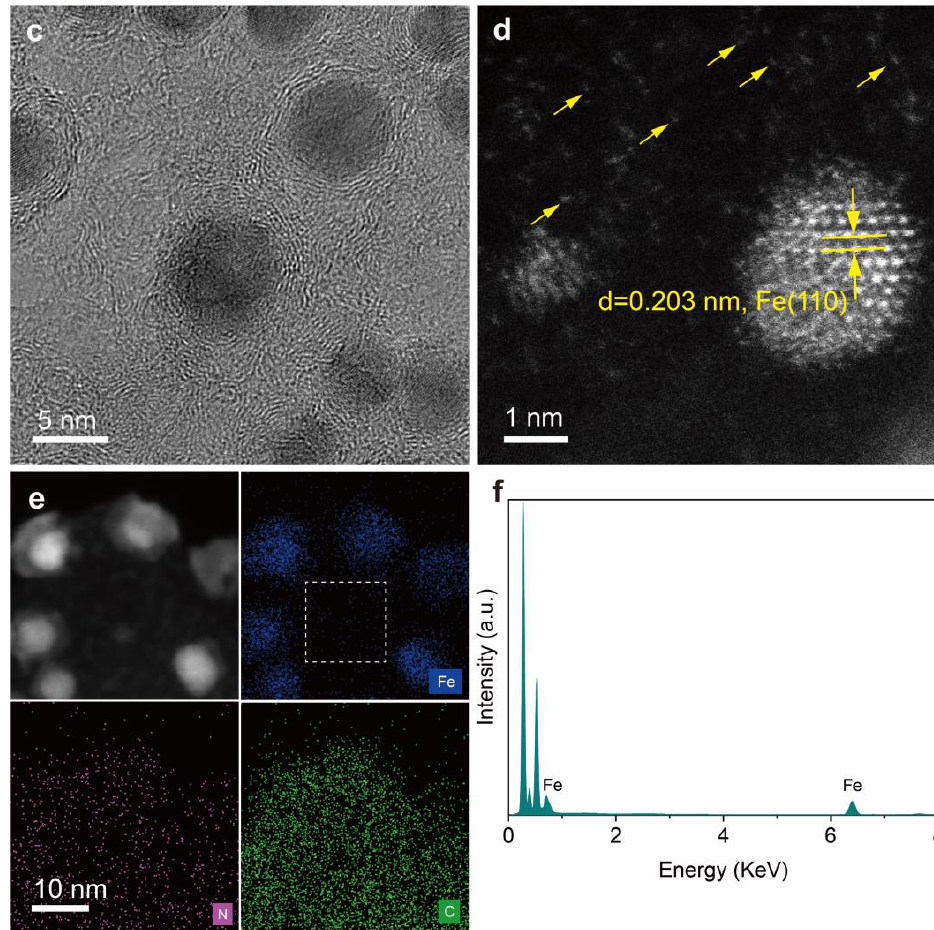
Figure 2. Microstructural characterizations of Fe@Fe-SAC. ( a ) SEM image, ( b ) TEM image, ( c ) HRTEM image, and ( d ) atomic resolution HAADF-STEM image of Fe@Fe-SAC (a portion of single atoms are indicated by yellow arrows). ( e ) HAADF-STEM and corresponding elemental mapping images. ( f ) EDS of the carbon substrate (marked by a square in e